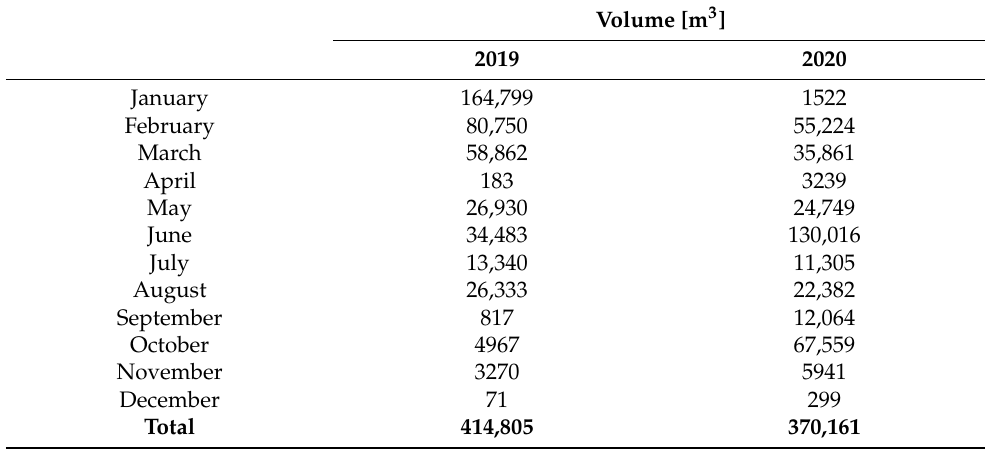
Table 2. Monthly volumes of untreated or ‘poorly treated’ wastewater released from the wastewater treatment plant into Site 4 in 2019 and 2020.